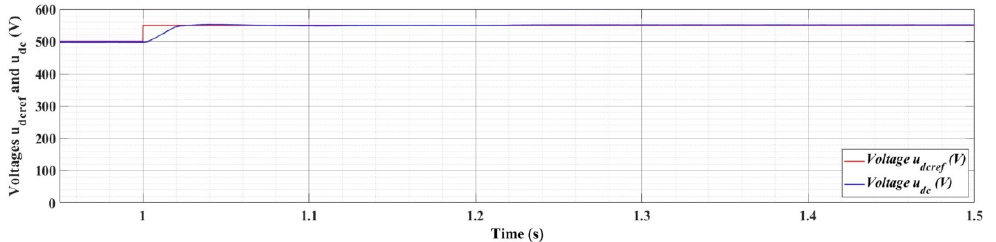
Figure 46. The time evolution of voltage u dc for a step variation of the u dcref reference voltage from 500 V to 550 V using SMC- and SYN-type controllers (signal evolution of the type 2 PV array).